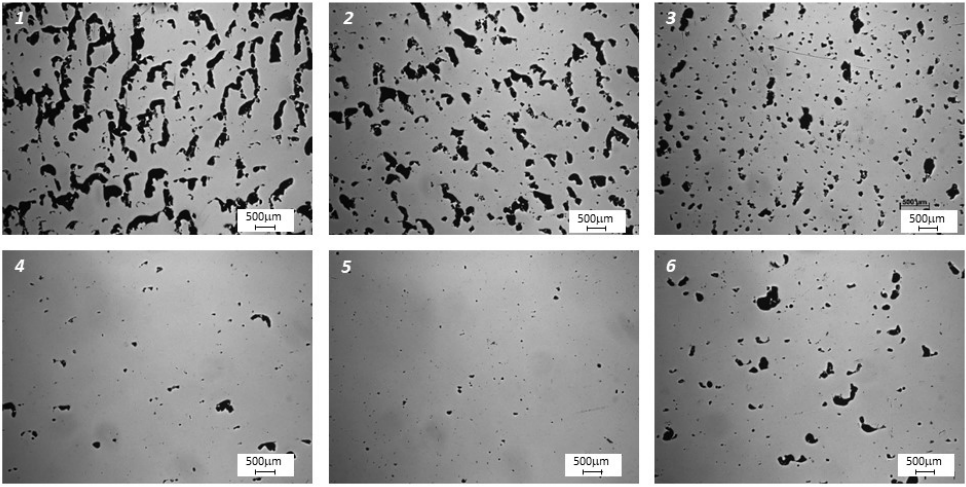
Figure 4. LOM images showing the defects (within the horizontal cross sections) on the nonetched surface of the M789 steel built via AM. Images ( 1 ) to ( 6 ) correspond to the sample numbers and printing parameters provided in Table